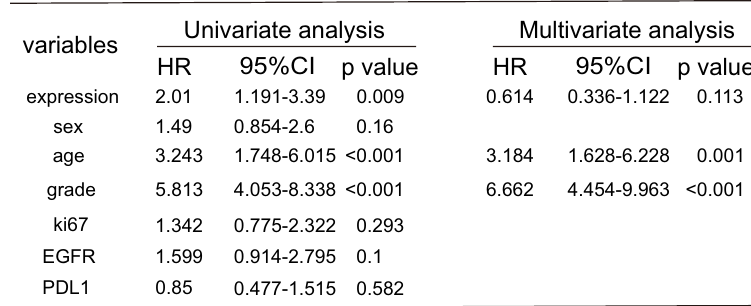
Figure 5. Up-regulated TIMP1 expression is associated with poor outcomes of GBM. ( A ) Representative IHC images of TIMP1 staining in GBM tumors (magnification, ×3 and ×20 ). Blue color indicates staining for nuclei and brown color indicates staining for TIMP1 protein. ( B ) Kaplan–Meier analysis of overall survival and diseasE−free survival of 180 glioma patients. The low expression and high expression of TIMP1 were grouped by the IHC total score. Data were analyzed by log-rank test. ( C ) Univariate and multivariate regression analyses of TIMP1 for overall survival in glioma patients. Ki67 antigen identified by monoclonal antibody Ki-67, EGFR epidermal growth factor receptor, PDL1 programmed cell death